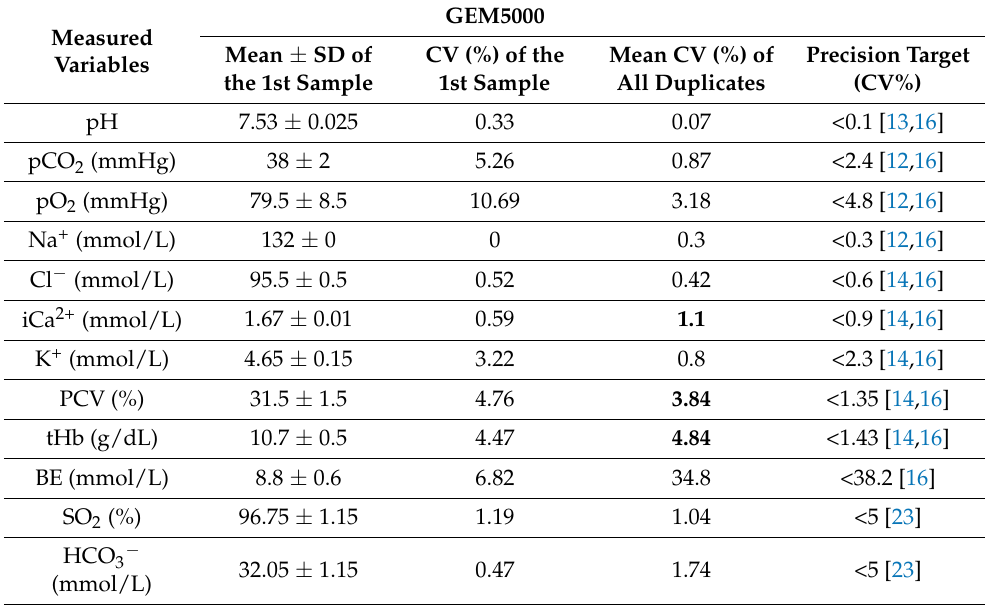
Table 1. Mean values and standard deviation, and coefficient of variation of the first sample as well as the mean CV for all 29 duplicate measurements of blood samples on the GEM5000 analyzer. Measured Variables